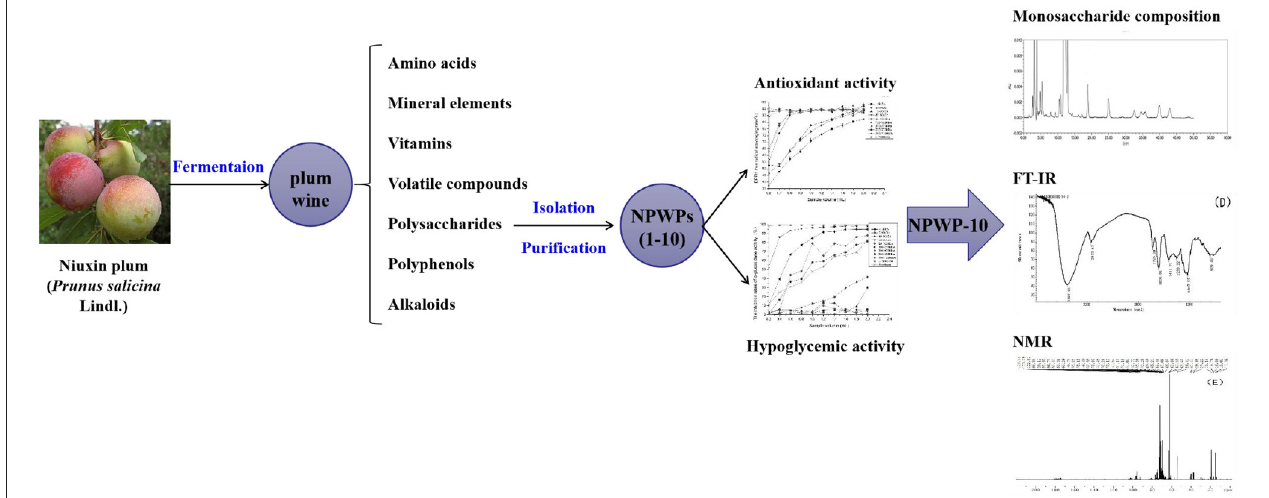
GRAPHICAL ABSTRACT | Evaluation of bioactive compounds and bioactivities in plum ( Prunus salicina Lindl.) wine.